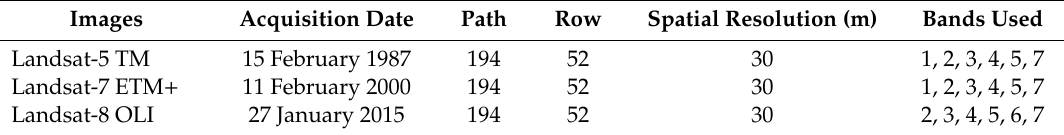
Table 1. Landsat images used for mapping irrigated areas in the Mogtedo region, Burkina Faso.